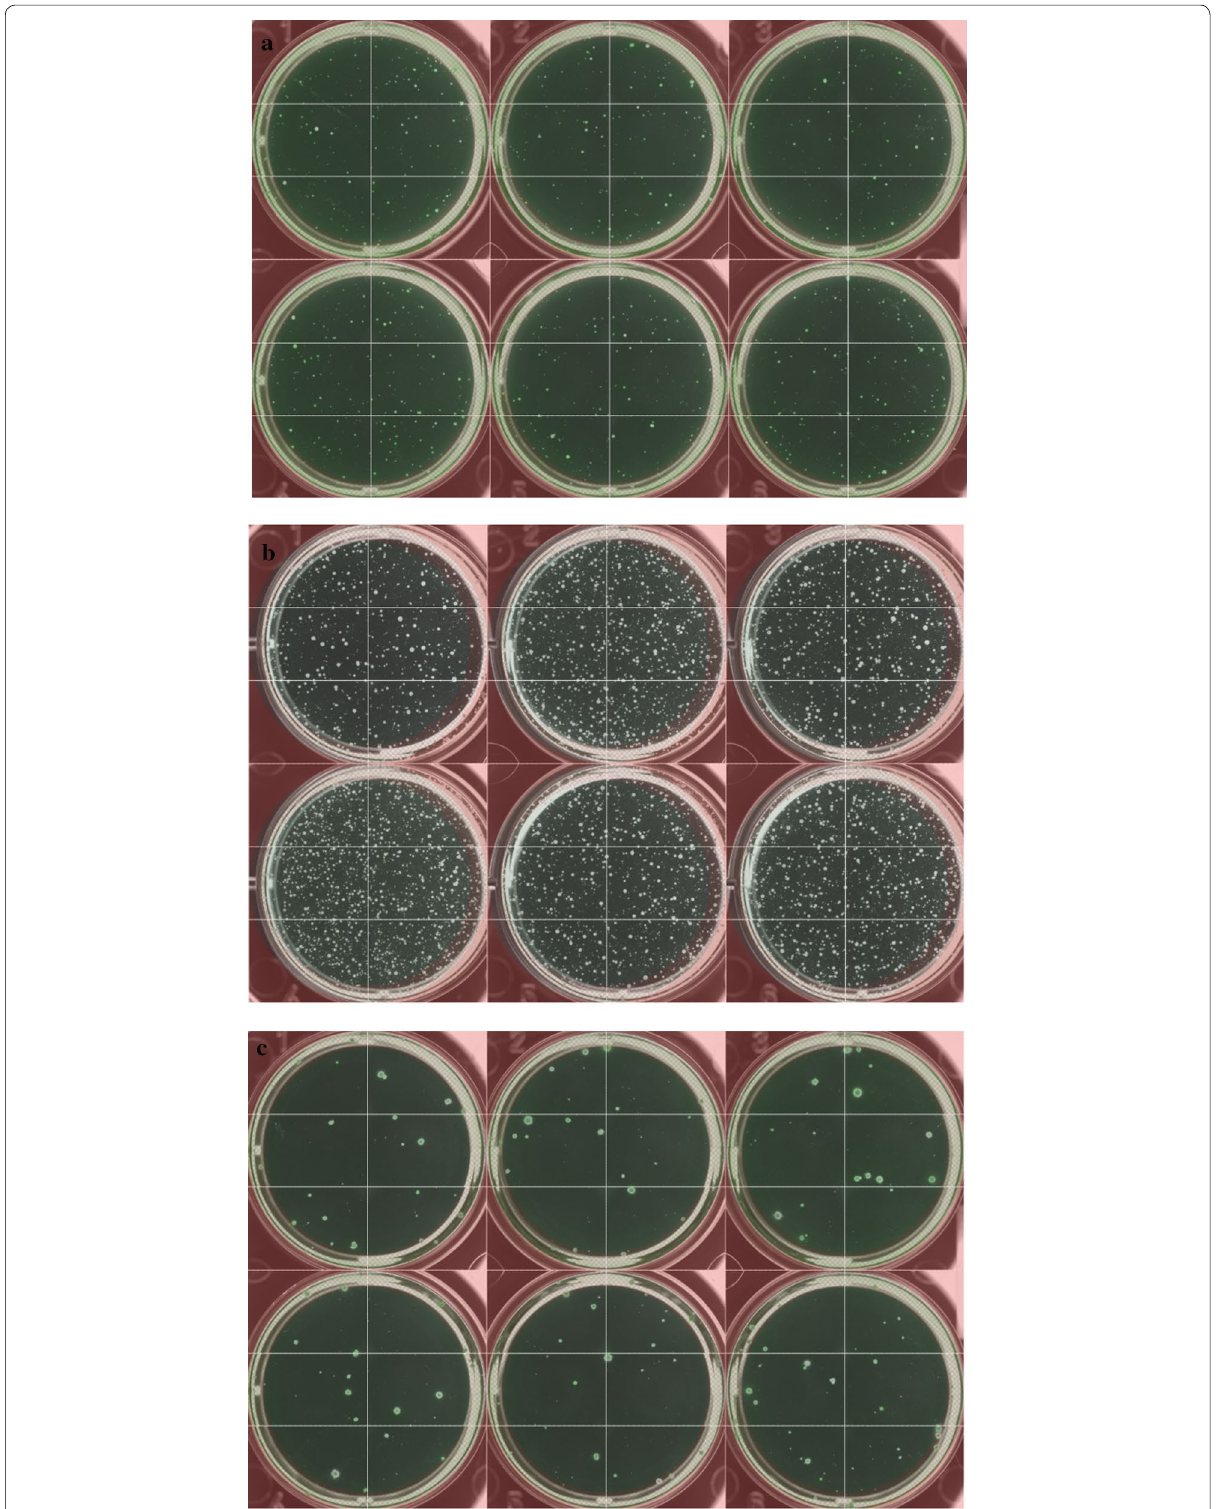
Fig. 2 ClonePix2 images comparing colonies from a CDM1/CloneMatrix mixtures, b CDM2/CloneMatrix mixtures, and c CDM3/CloneMatrix